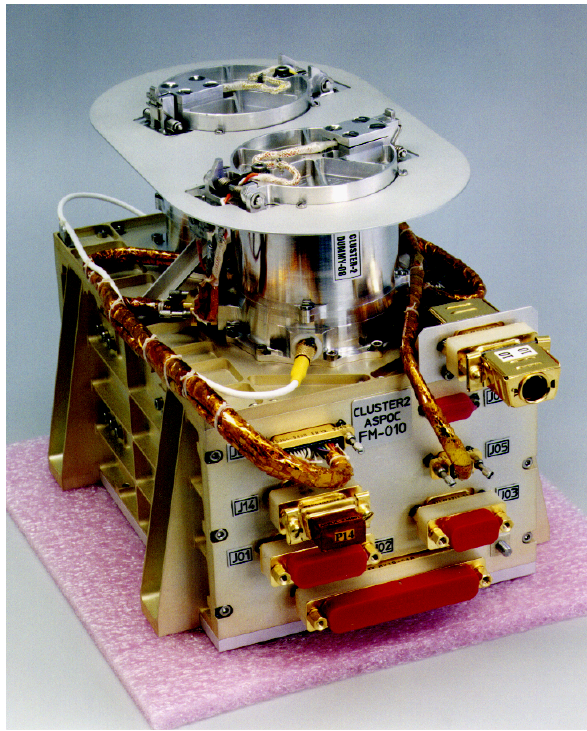
Fig. 4. Photo of the instrument.